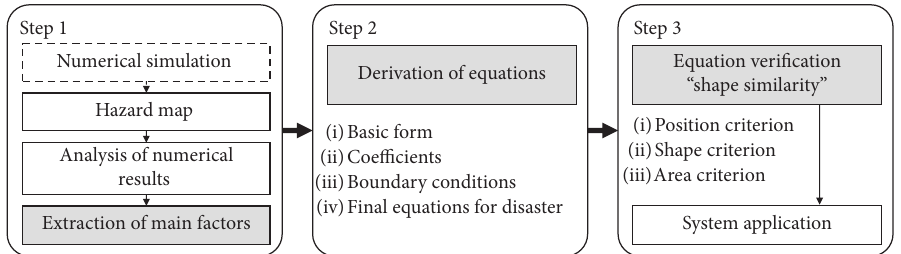
Figure 1: Progress of the SIND model (Kim et al. [31]).